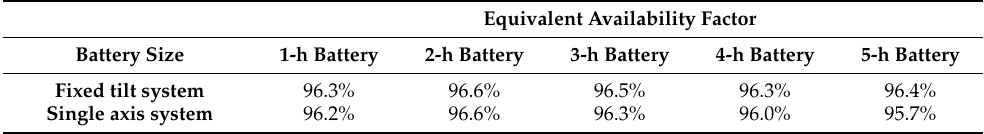
Table 7. EAF for battery during